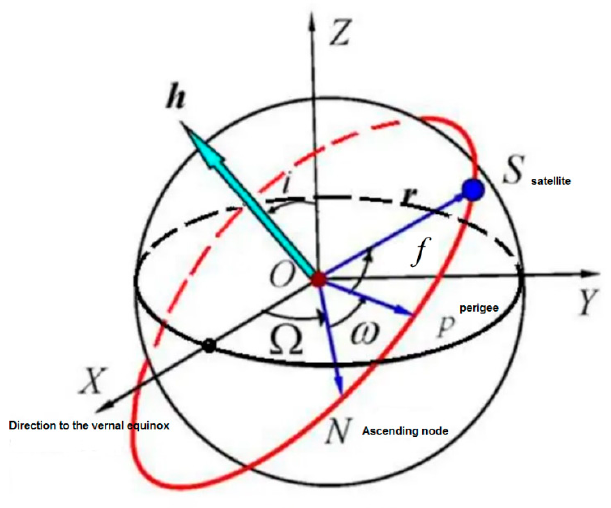
Figure 12. Schematic diagram of the six orbital elements.